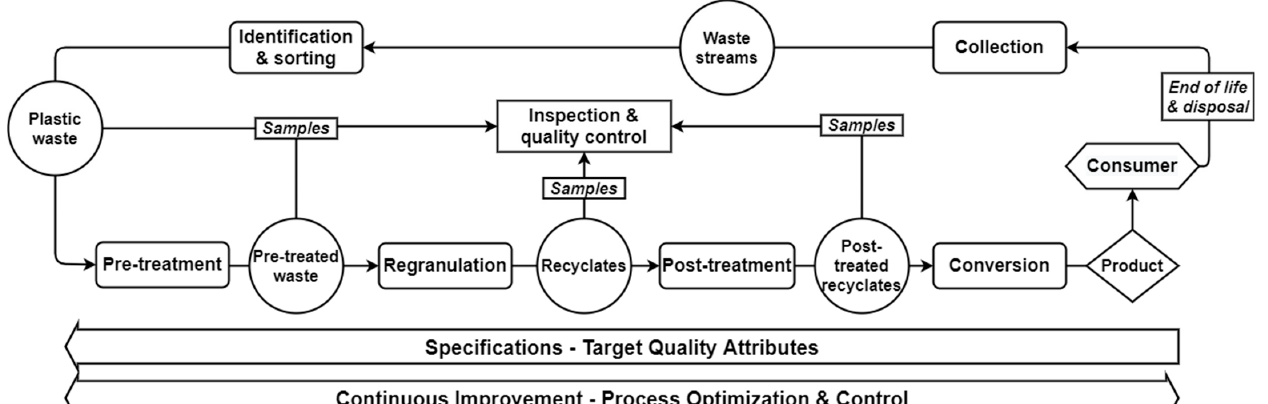
Figure 3. Recycling process of plastic waste together with an indication of reasonable sampling at different stages to enable adequate process control for high-quality recyclates (own illustration).